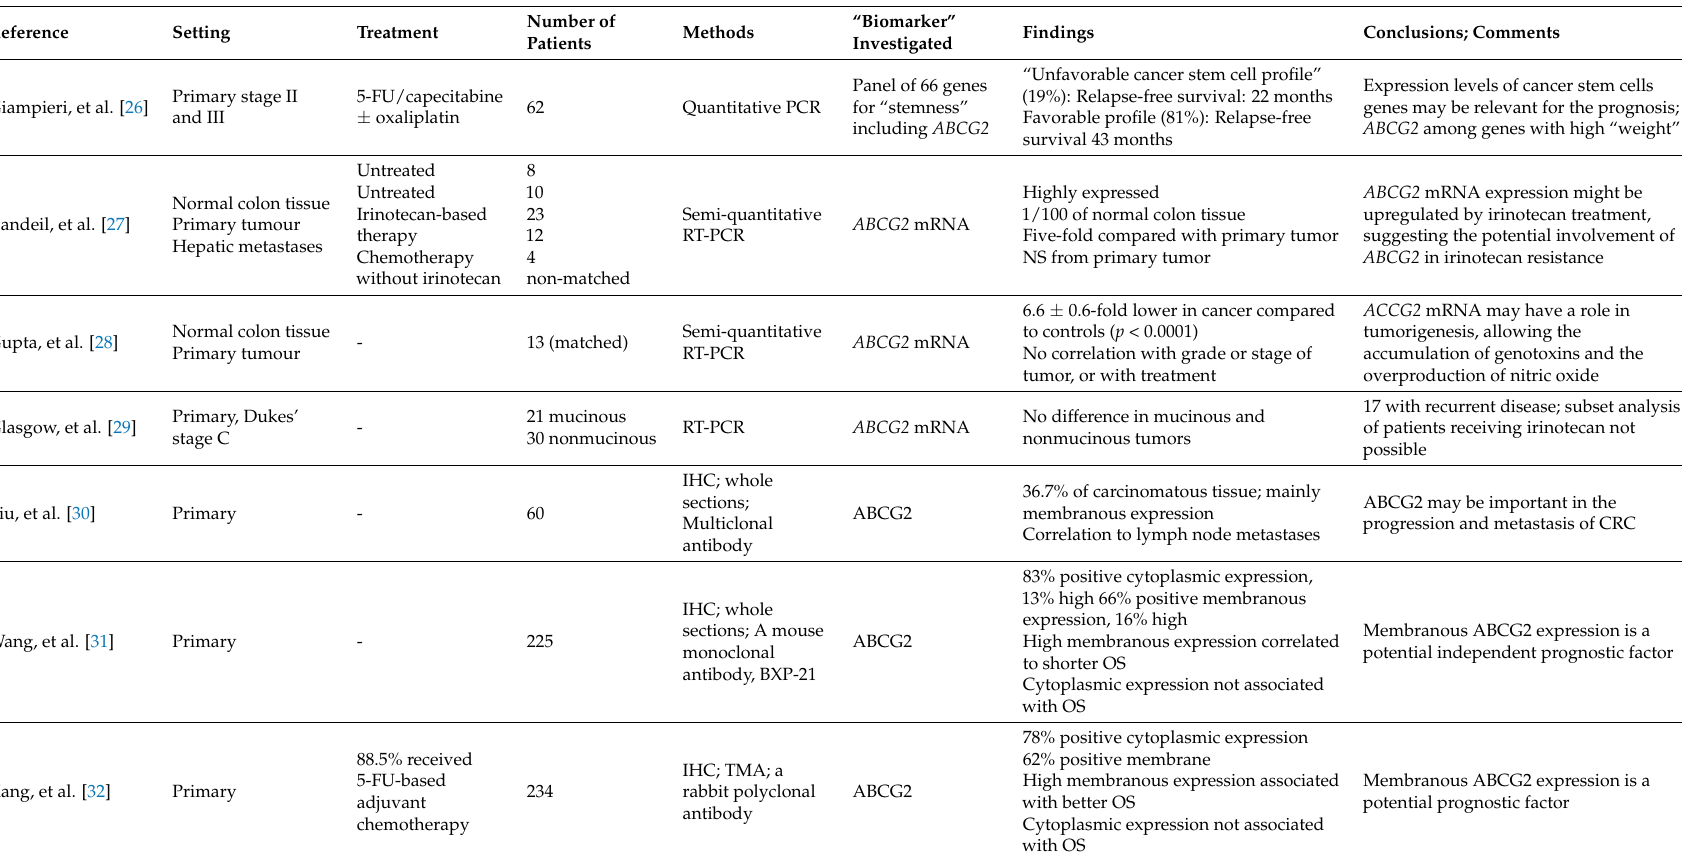
Table 1. Studies of ABCG2 gene and protein expression in CRC in relation to expression pattern and/or